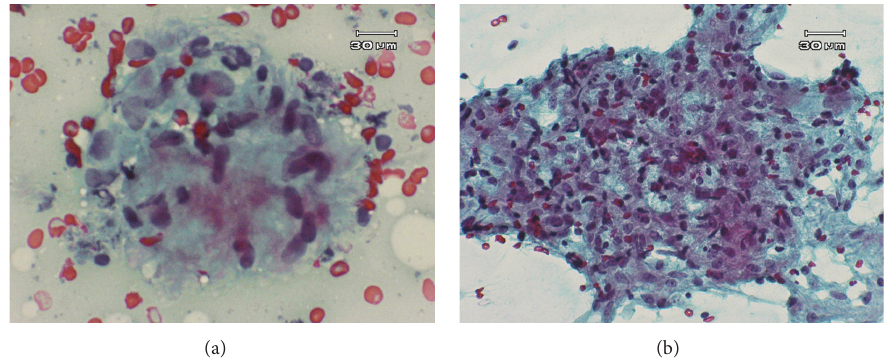
Figure 3: Cytohistopathological findings obtained from EBUS-TBNA specimen. (a) Noncaseating granuloma composed of epithelioid histiocytes with abundant cytoplasm (Pap stain × 400). (b) Larger aggregates of epithelioid histiocytes with admixed lymphocytes forming a large noncaseous granuloma (Pap stain ×